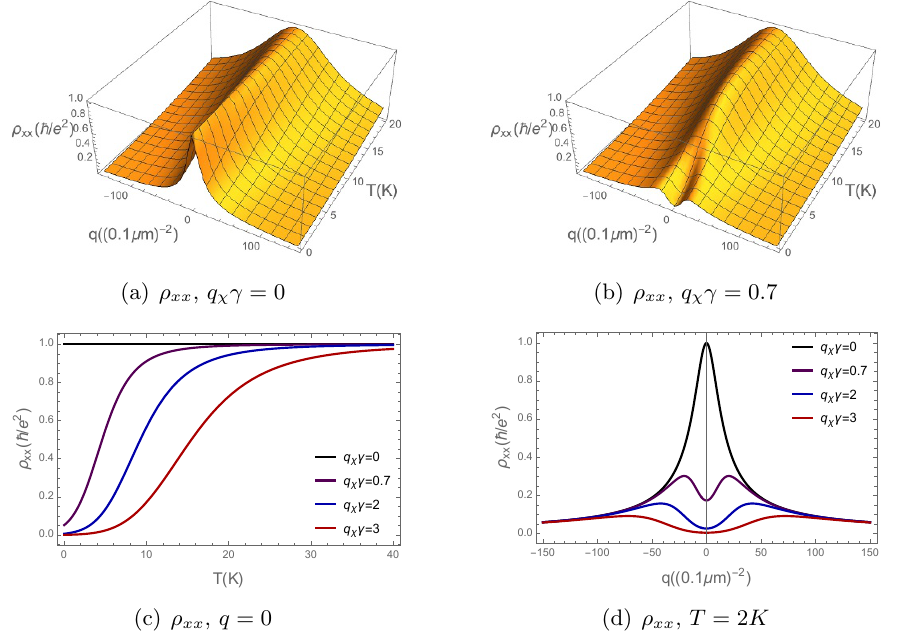
Figure 12 . The charge and the temperature dependence of the longitudinal resistivity without (a) and with (b) magnetic impurity. (c) The temperature dependence of (cid:26) xx at the charge neutral point and (d) The charge density dependence of (cid:26) xx at low temperature ( T = 2 K ) with di(cid:11)erent value of q (cid:31) (cid:13)